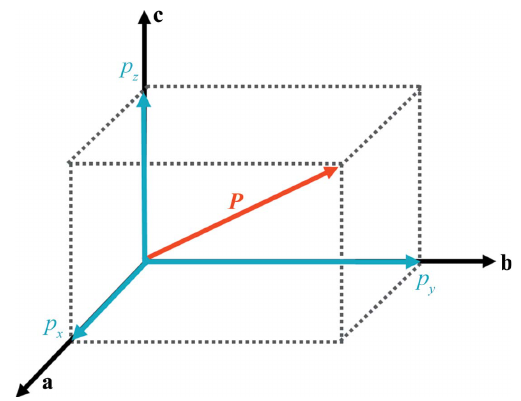
Figure 1 Dipole moment P is a vector. In a crystallographic coordinate system, it can be expressed as P = p x i + p y j + p z k . Where i , j , k are the unit vectors, p x , p y and p z represent the dipole moment components along crystal- lographic a , b and c axes,